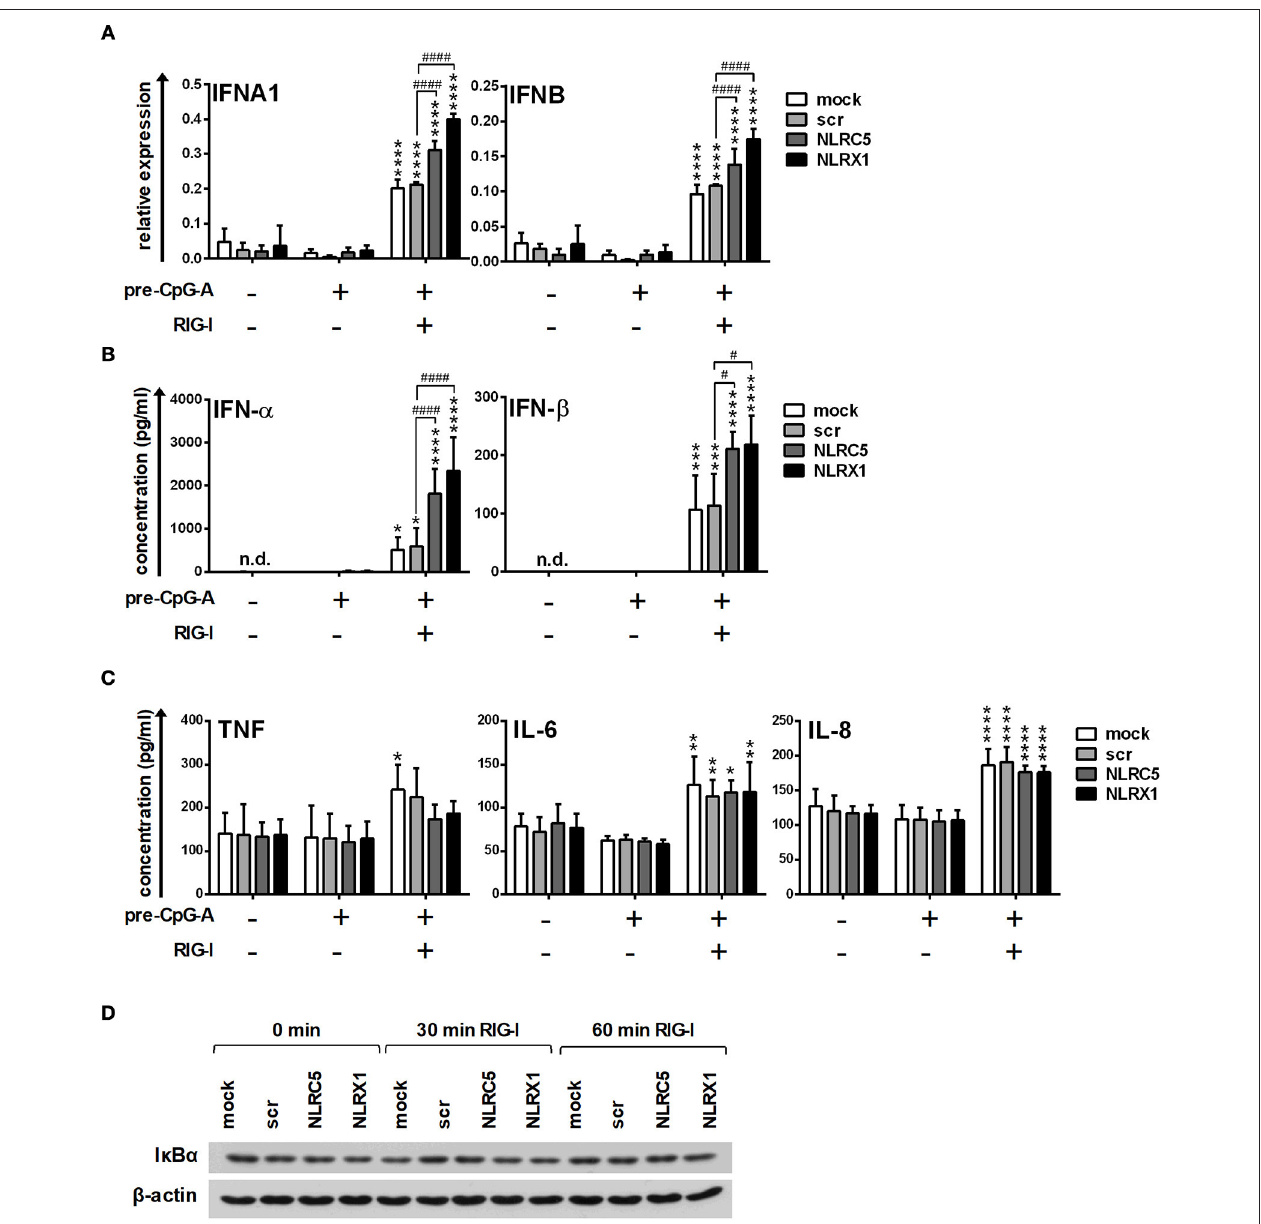
FIGURE 3 | The specific RIG-I agonist-induced type I IFN production is upregulated by NLRC5 or NLRX1 silencing while the NF- κ B signaling pathway is not affected in GEN2.2 cells. (A–D) Cells were transfected with siRNAs specific for NLRC5, NLRX1 or scrambled (scr) siRNAs for 24h then pre-treated with 0.25 µ M CpG-A (pre-CpG-A) for 16h to induce the cytosolic expression of RLRs. Following thorough washing steps cells were stimulated with the specific RIG-I agonist 5 ′ ppp-dsRNA (RIGL, 1 µ g/ml). The IFNA1 and IFNB mRNA expression levels were assessed by real-time PCR after 3h (A) and IFN- α , IFN- β (B) , TNF, IL-6, and IL-8 (C) protein levels were measured by ELISA after 6 (B) or 24h (C) . (D) Kinetics of I κ B α degradation was determined by western blotting. (D) A representative blot is shown. (A–C) Data are represented as means ± SD of 3-5 individual experiments and analyzed using one-way ANOVA followed by Bonferroni’s post-hoc test. * p < 0.05, ** p < 0.01, *** p < 0.001, **** p < 0.0001 vs. pre-CpG-A-treated samples; # p < 0.05, #### p < 0.0001, n.d., not